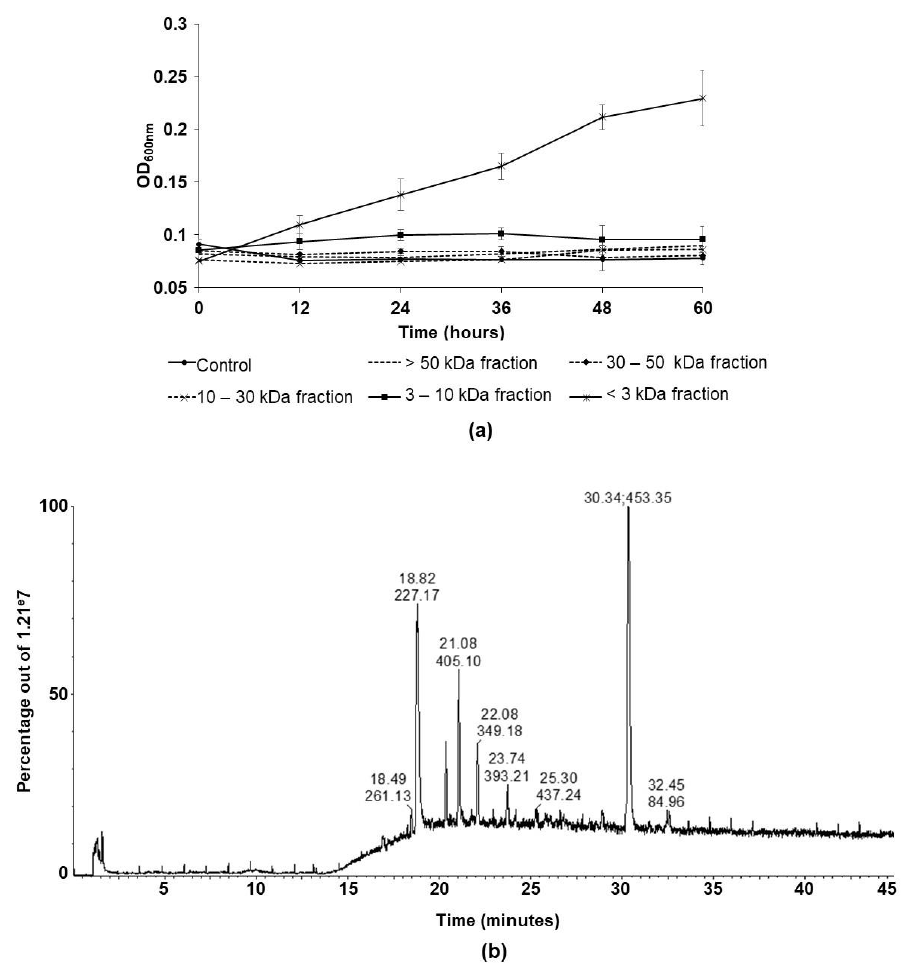
Figure 4. ( a ) Follow-up of B. velezensis growth in microplate in monocultures supplemented with different fractions of T. harzianum ’s supernatant containing, respectively, the molecules of molecular weight higher than 50 kDa, between 30 and 50 kDa, 10 and 30 kDa, 3 and 10 kDa and lower than 3 kDa, ( b ) Total ion chromatogram obtained by RPC18-HPLC-qTOF for T. harzianum ’s supernatant’s fraction containing molecules of molecular weight less than 3 kDa. The retention time and the value of the most intense m/z constituting each notable peak are indicated at the top of the peak.